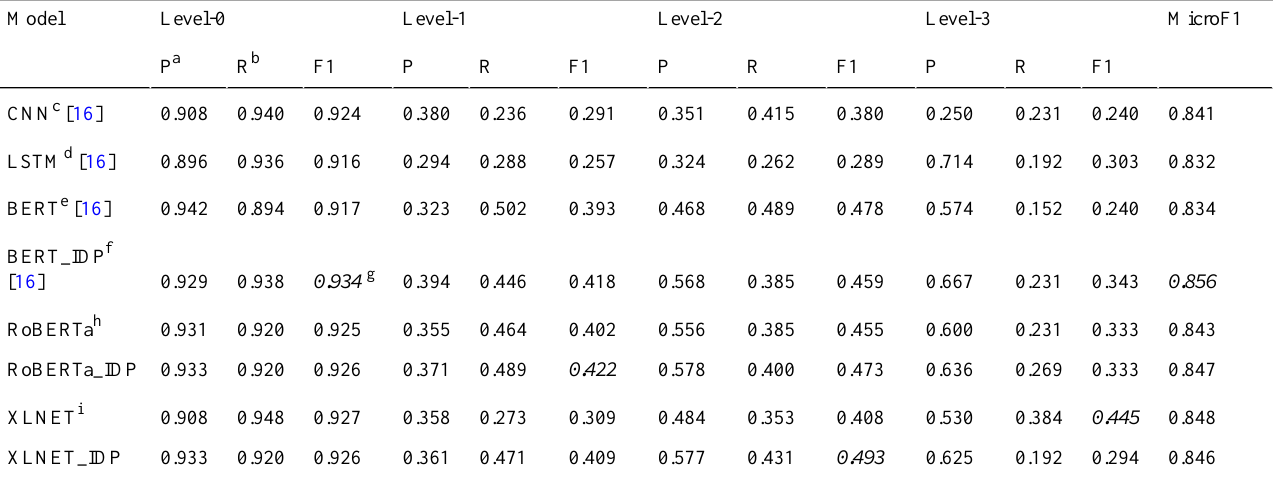
Table 5. Performance of deep-learning methods with different language representation models.